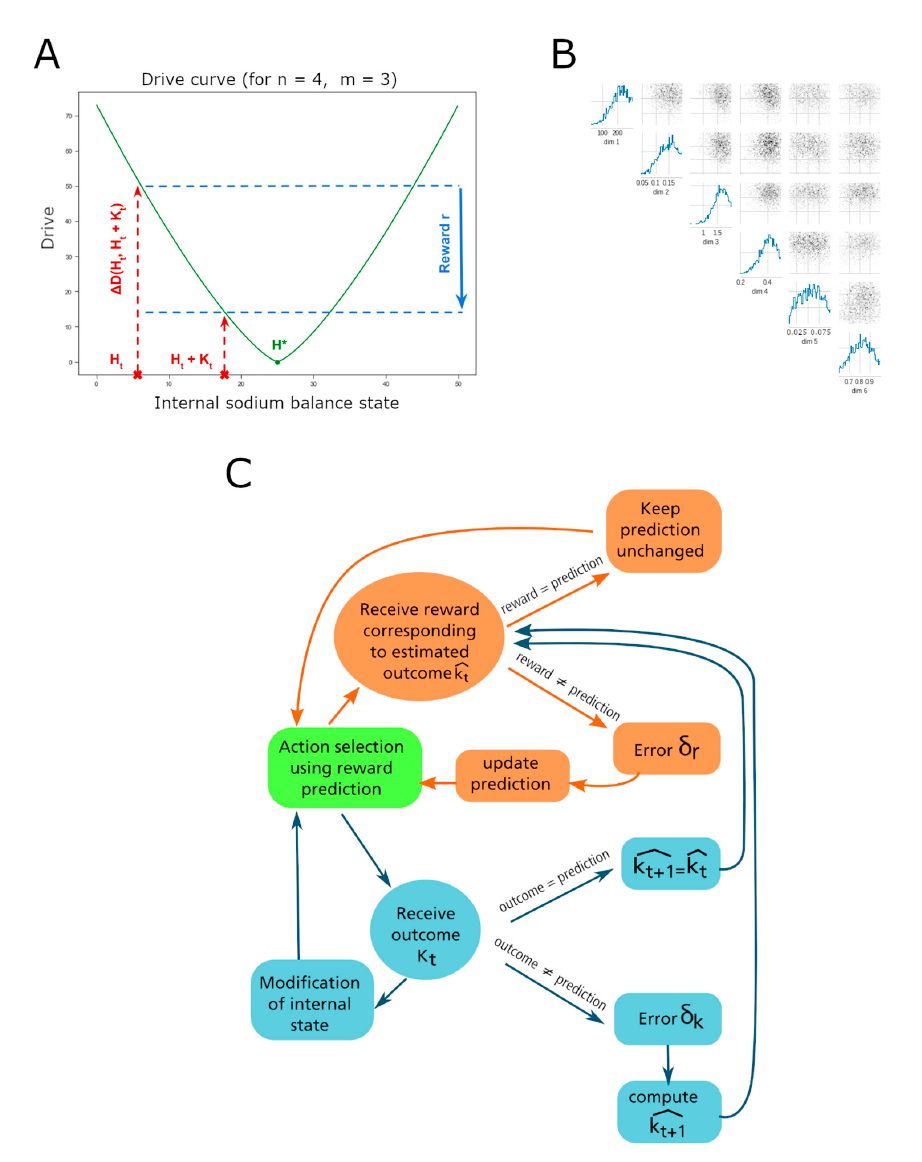
Figure 1. ( A ) Drive as a function of the internal sodium level. The optimal sodium level is denoted by H* , indicated by a dot. The current sodium state of the agent at time t is H t . An action apports an outcome that impacts the sodium level denoted by K t , transitioning the internal state to H t + 1 = H t + K t . The change in the drive function is defined as the reward r = ∆ D ( H t , H t + K t ). ( B ) Probability distributions for parameter values yielding model results consistent with the experimental observations. Parameters are, from top to bottom: the setpoint H* , the learning rate 𝜖 , the rate of exploration 𝛽 , the fixed outcome K , the loss of sodium after each trial and the energy cost of drinking. If each parameter takes a value with a high probability, the simulation results are consistent with the experimental observation. For each pair of parameters, the joint probability distribution that the two parameters fall in their respective range of possible values is also represented. Distributions obtained following Gonçalvez et al. [30], see Methods for details. ( C ) Diagram of the agent computations during a single trial (adapted from Schultz [31]). After performing an action, the agent receives a reward computed with the drive function and the estimated outcome of the action. The reward prediction error will be used to update the predicted value of this action and the probability of the agent to choose it at the next trial. In the meantime, the agent receives the outcome of the action, which modifies its internal state and its prediction of this